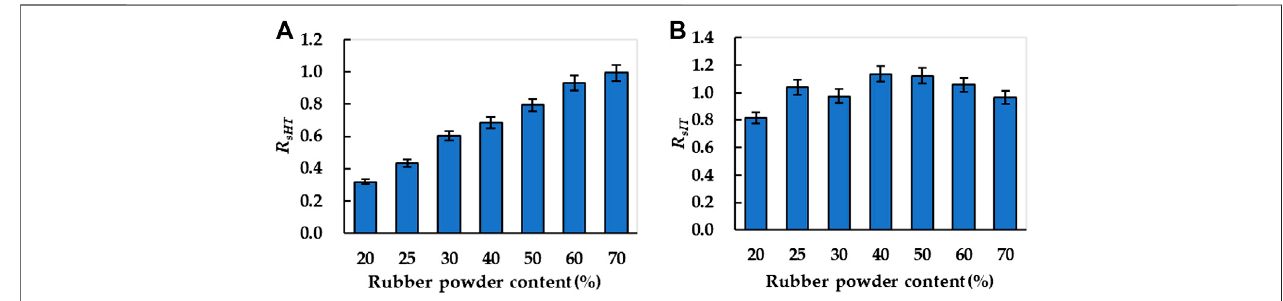
FIGURE 8 | The variation of segregation rate with the amount of the rubber powder. (A) High temperature. (B) Medium temperature.